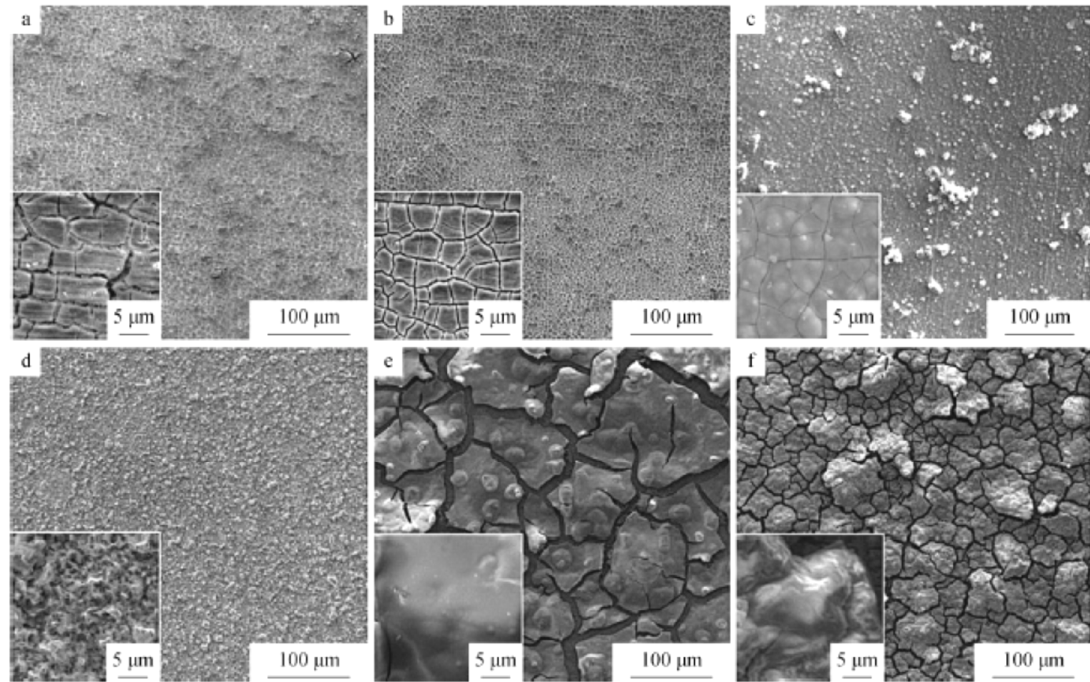
Figure 6. Surface SEM images of Mo layer deposited under different current densities: ( a ) 0.25 mA ∙ cm − 2 , ( b ) 0.5 mA ∙ cm − 2 , ( c ) 0.75 mA ∙ cm − 2 , ( d ) 1.0 mA ∙ cm − 2 , ( e ) 2.5 mA ∙ cm − 2 , and ( f ) 5.0 mA ∙ cm − 2 in